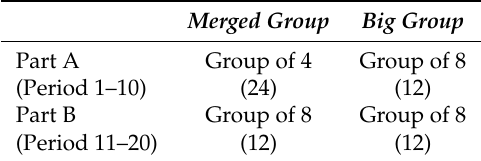
Table 2. Treatment